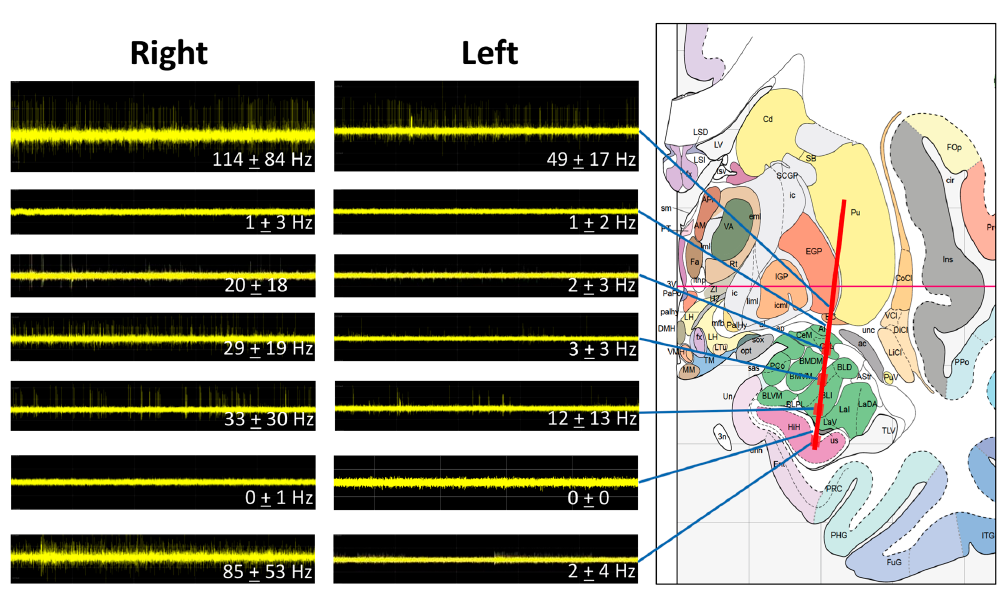
Figure 2. MER signals at different sites along the trajectory of the microelectrode. The predicted trajectory has been superimposed to a stereotactic brain atlas [14]. The MERs match the predicted anatomy with higher frequencies noted in the GPe, the amygdala and the hippocampus. The right side shows a higher frequency than the left side. The entrance and the exit from the amygdala are marked by a drop in background activity.